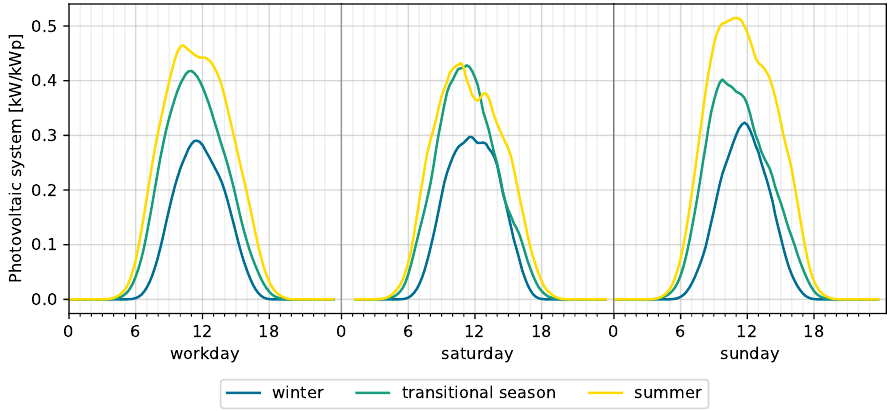
Figure 2. Normalized generation of the PV system for the northeast location with southern